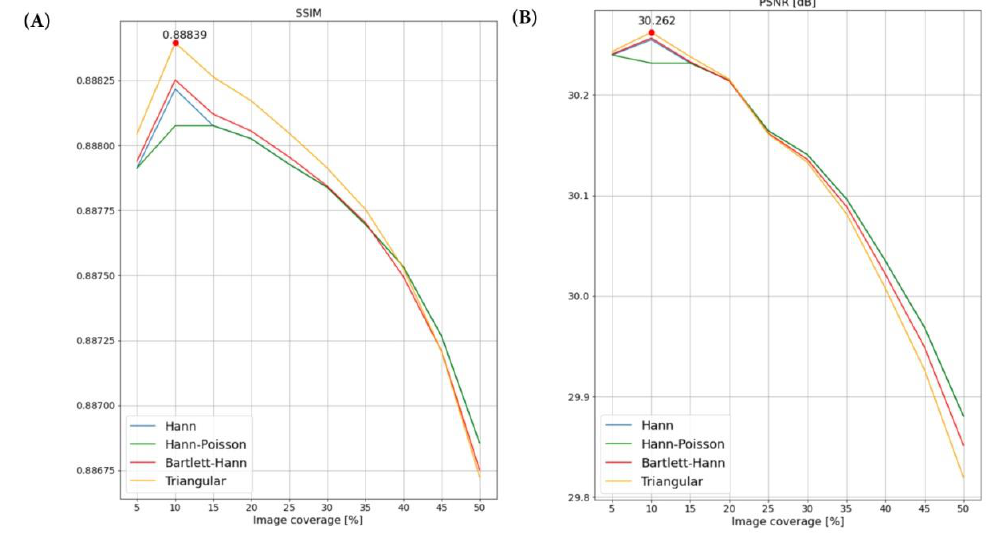
Figure 10. The values of the SSIM and PSNR metrics for the image presented in Figure 9.